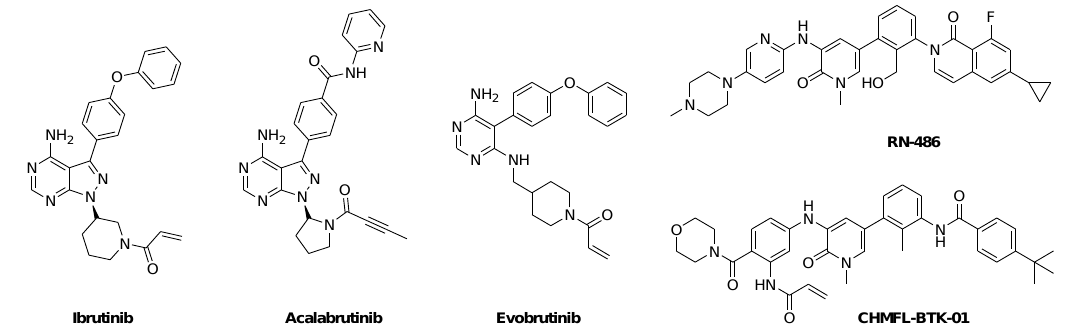
Figure 1. Examples of FDA-approved and preclinical BTK inhibitors.